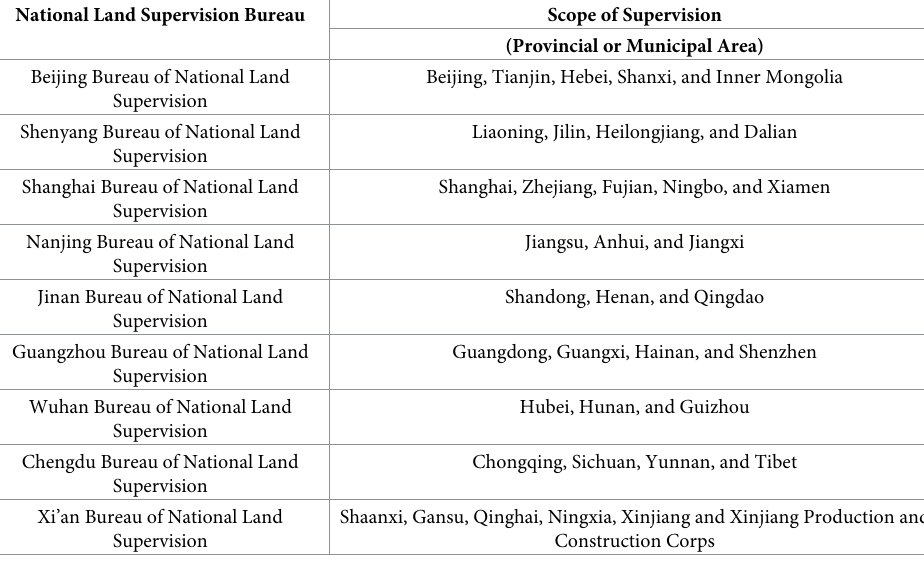
Table 1. National Land Supervision Bureaus and their supervision